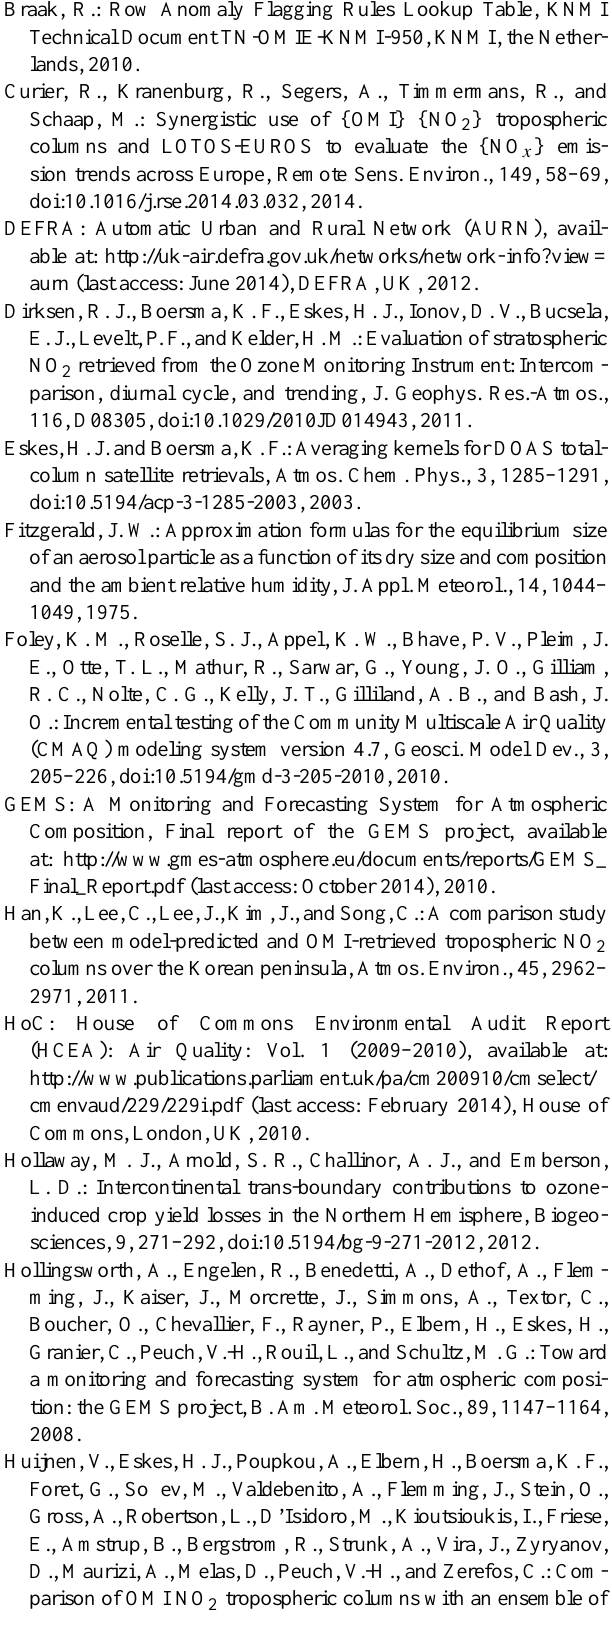
Braak, R.: Row Anomaly Flagging Rules Lookup Table,